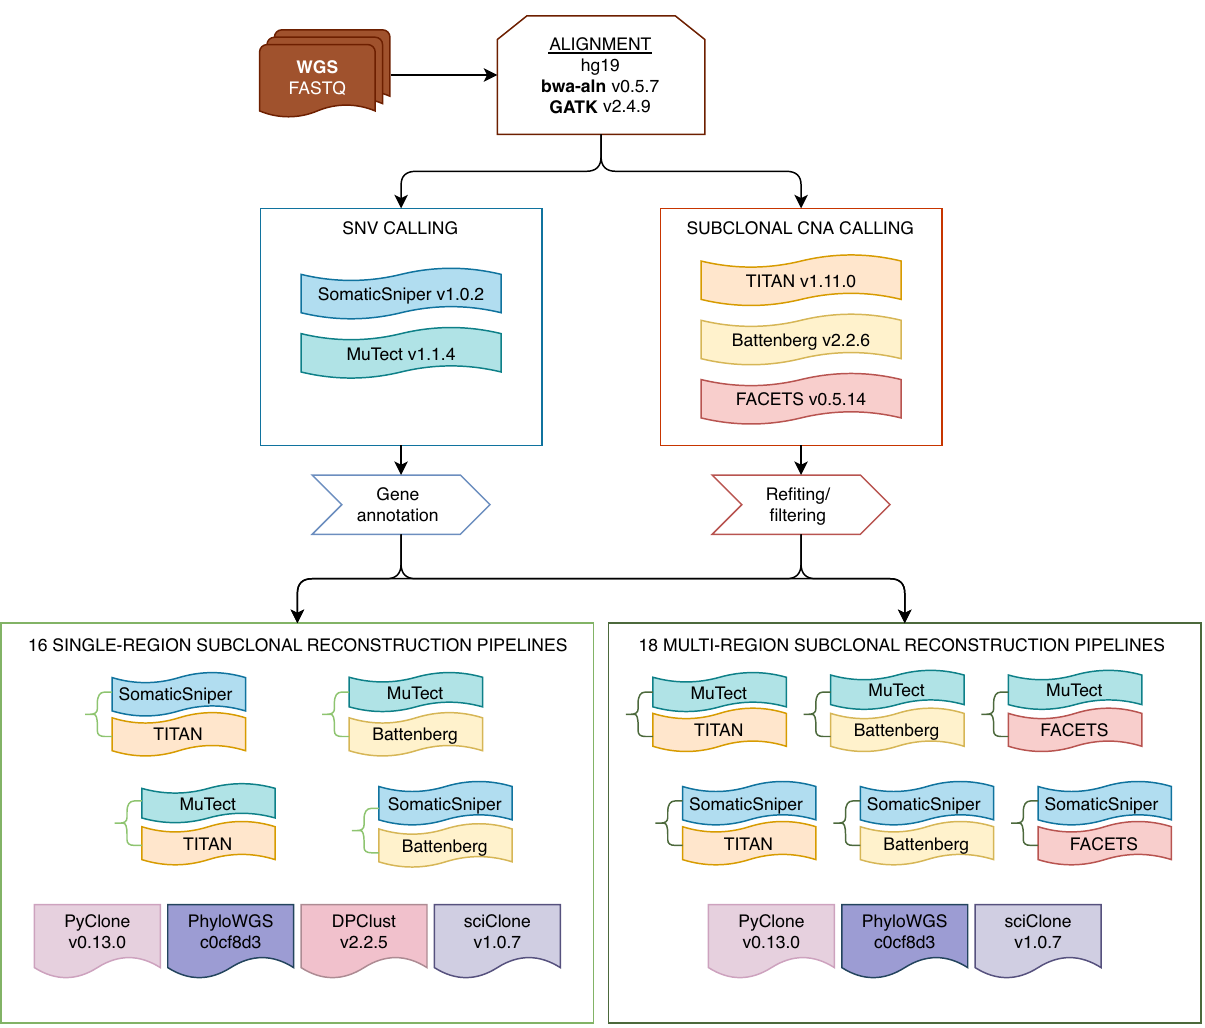
Fig. 1 Subclonal reconstruction work fl ow and pipeline construction. Raw sequencing data from the tumour and normal samples were aligned against the hg19 build of the human genome using bwa-aln and GATK. Somatic SNVs were detected using SomaticSniper and MuTect and annotated for function. Somatic CNAs were detected using TITAN, Battenberg and FACETS and fi ltered. All single-region tumour samples had their subclonal architectures reconstructed using sixteen pipelines combining one of SomaticSniper and MuTect, one of Battenberg and TITAN, and one of PyClone, PhyloWGS, DPClust and SciClone. For tumours with samples from multiple regions, reconstructions of subclonal architectures were performed by considering each individual region alone and by considering samples from all regions together using eighteen pipelines. SNV, single nucleotide variant; CNA, copy number aberration; WGS, Consistency of subclonal architecture reconstruction . To eval- uate subclonal reconstruction solutions for 293 single-region tumours, we fi rst compared tumour cellularity (sometimes called “ tumour purity ” ) estimates across subclonal reconstruction pipe- lines. Cellularity estimates from CNA detection tools are inputs to PhyloWGS, PyClone and DPClust, and as expected, the predicted cellularity from pipelines using these algorithms correlated with those from the CNA detection tool used (TITAN: 0.212 – 0.623,